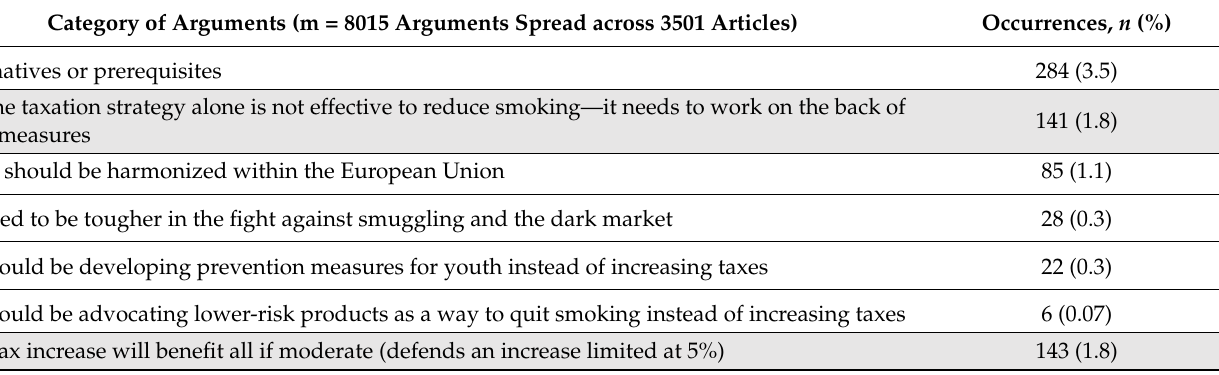
Table 4. Alternative proposals or prerequisites to tobacco tax